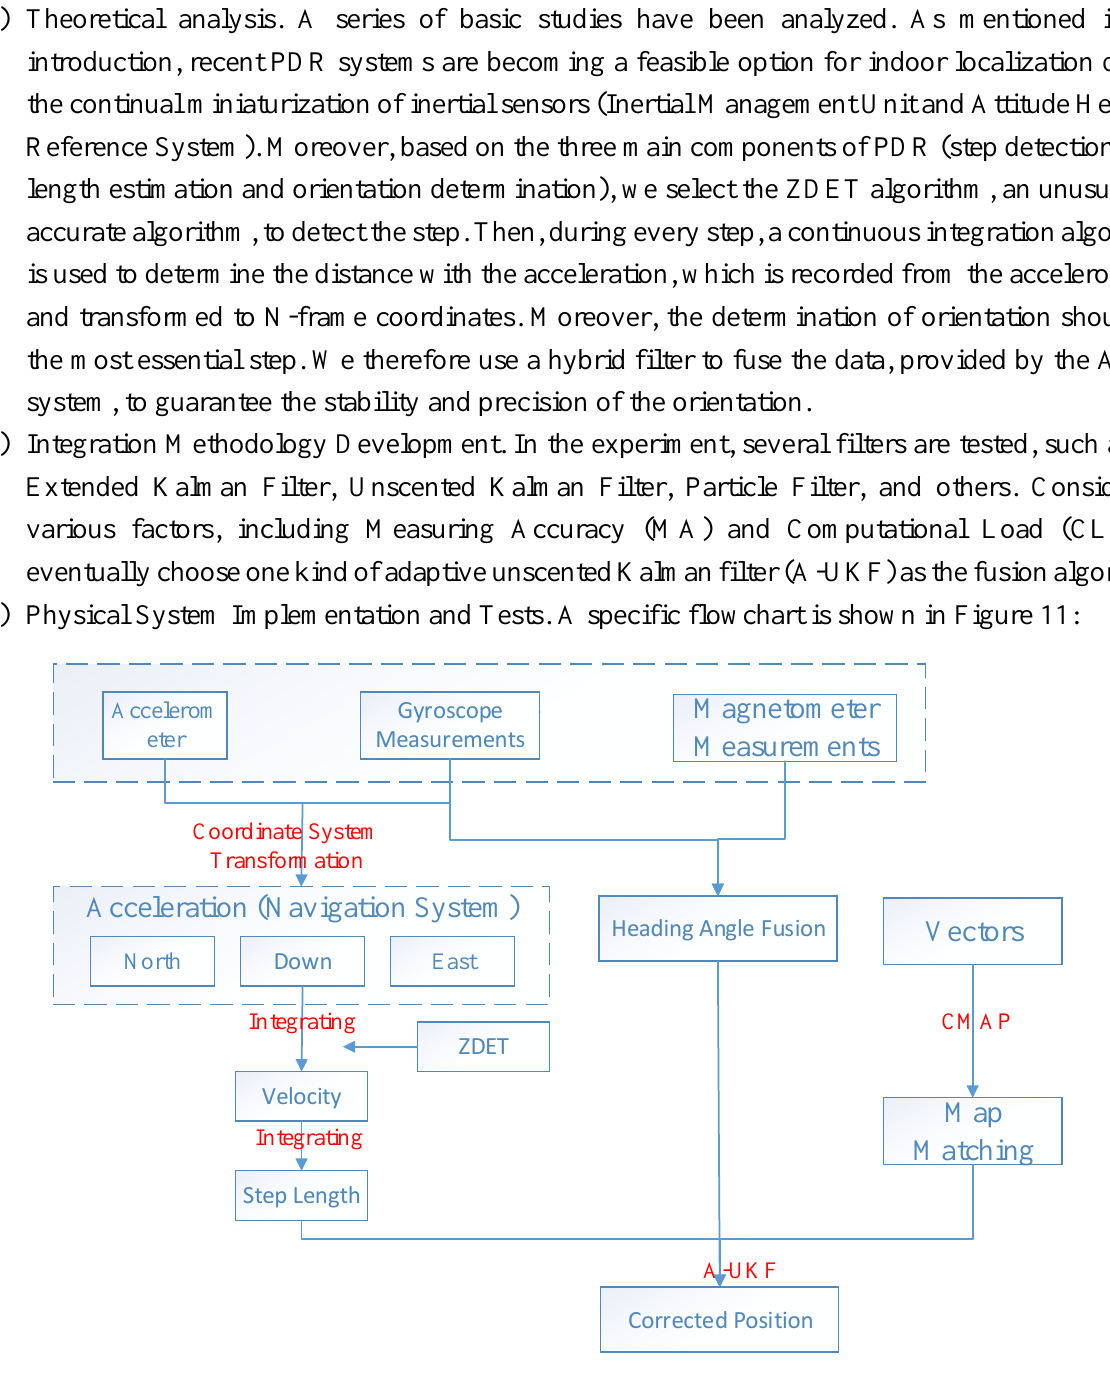
Figure 11. The general